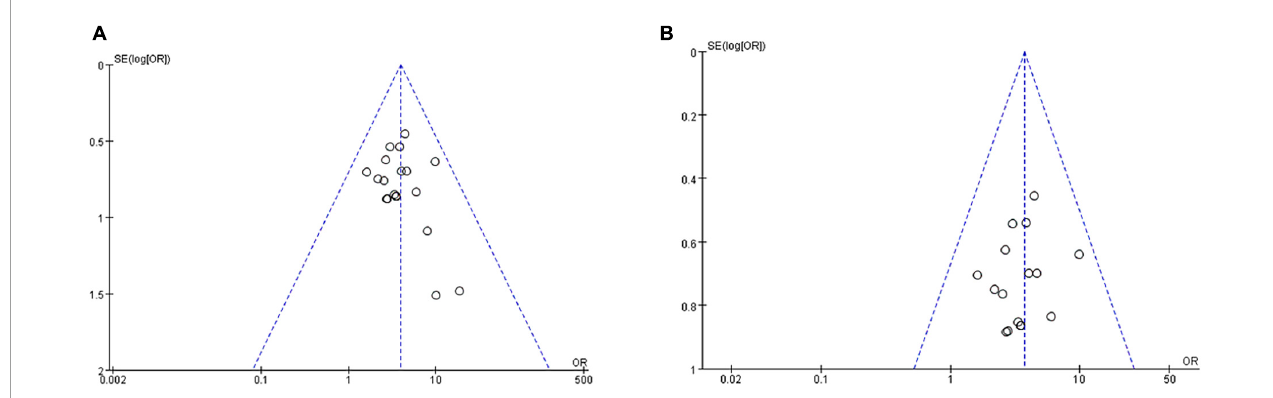
FIGURE10 The funnel plots for tuina for primary insomnia. (A) Before sensitivity analysis. (B) After sensitivity analysis.